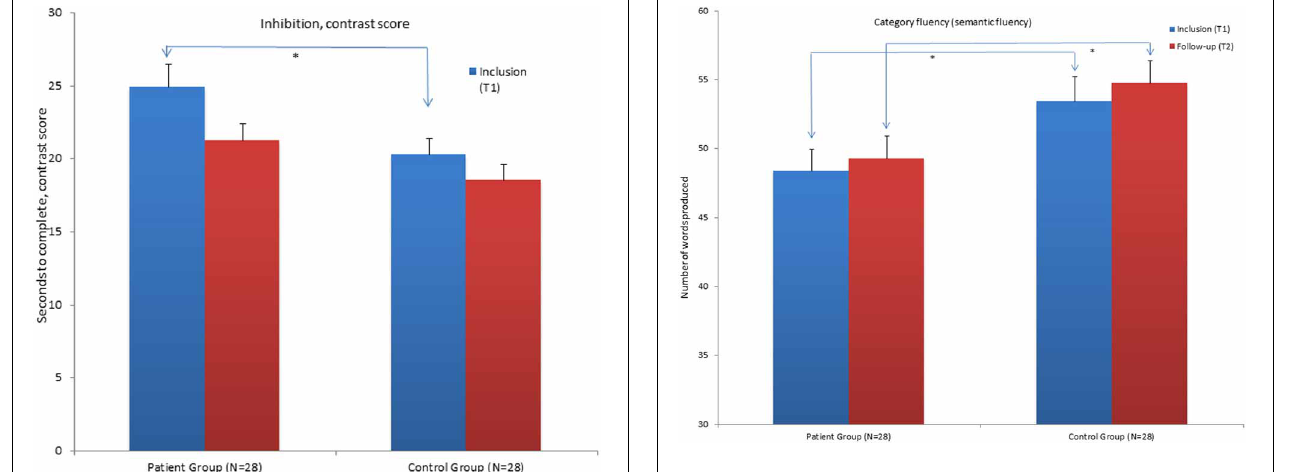
FIGURE 1 | Mean contrast scores for the Inhibition condition of the Color Word Interference Test (CWIT) for the patient group and control group at inclusion (T1) and at follow-up assessment (T2). ∗ Significant differences between the groups. Graphs represent mean Standard Error (SE).